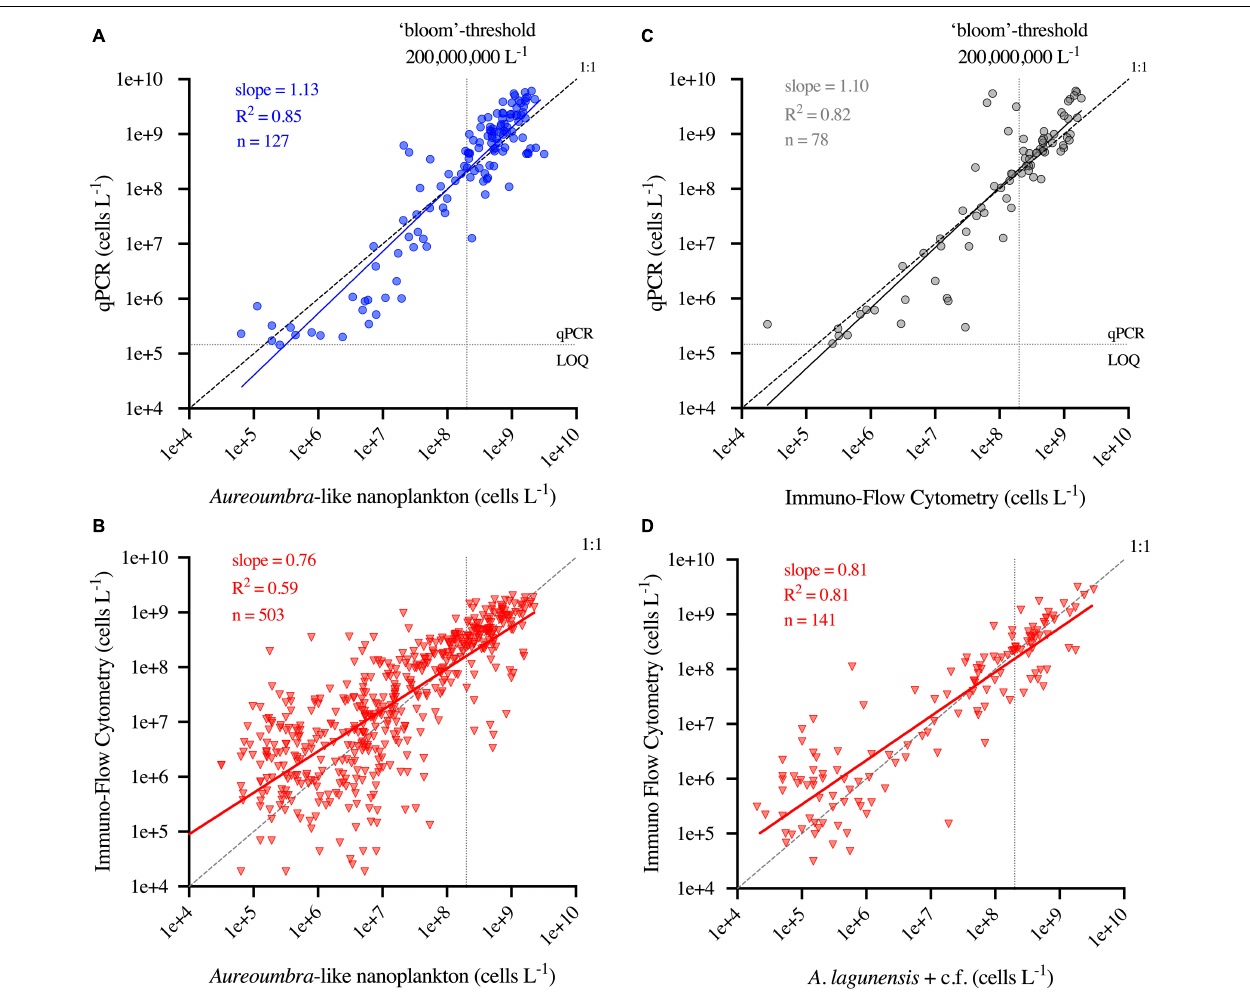
FIGURE 2 | (A) Regression between qPCR and microscopy counts for Aureoumbra -like cells. (B) Regression between immunofluorescence flow cytometry and microscopy counts for Aureoumbra -like cells. (C) Regression between qPCR and immunofluorescence flow cytometry. (D) Regression between immunofluorescence flow cytometry and summed microscopy counts of A. lagunensis + A. lagunensis c.f. from SJRWMD